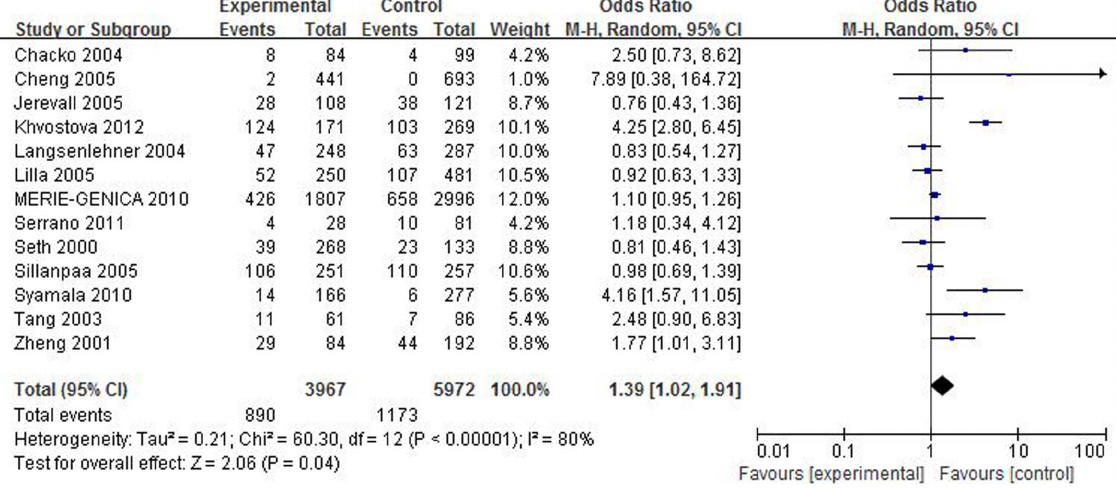
Figure 2. Forest plot on the association between SULT1A1 Arg213His polymorphism and breast cancer risk in homozygous model.